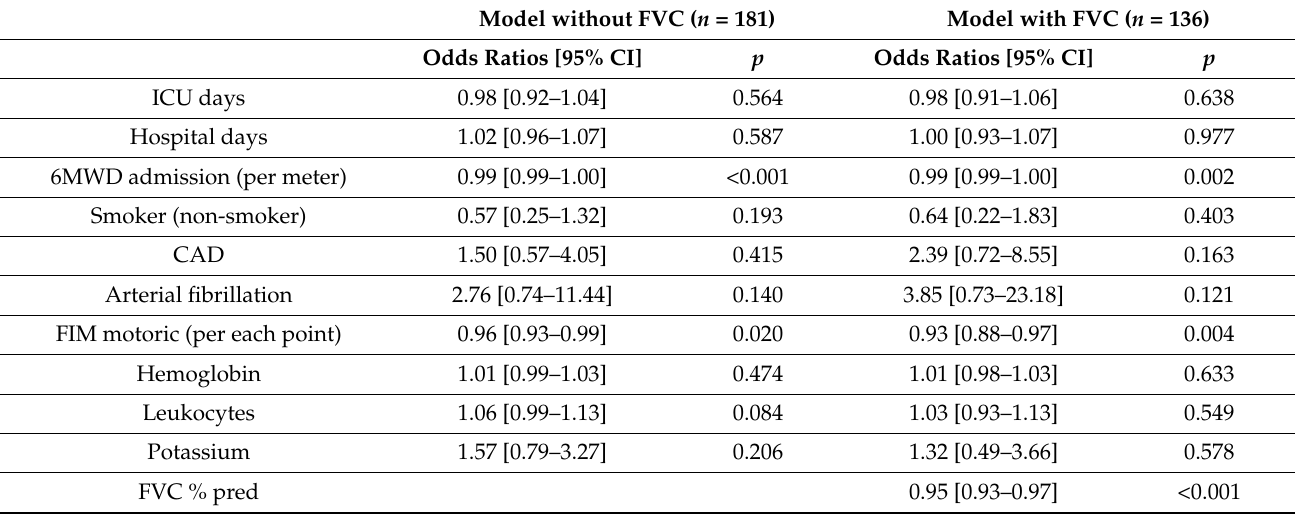
Table 5. Correlations models excluding and including Forced Vital